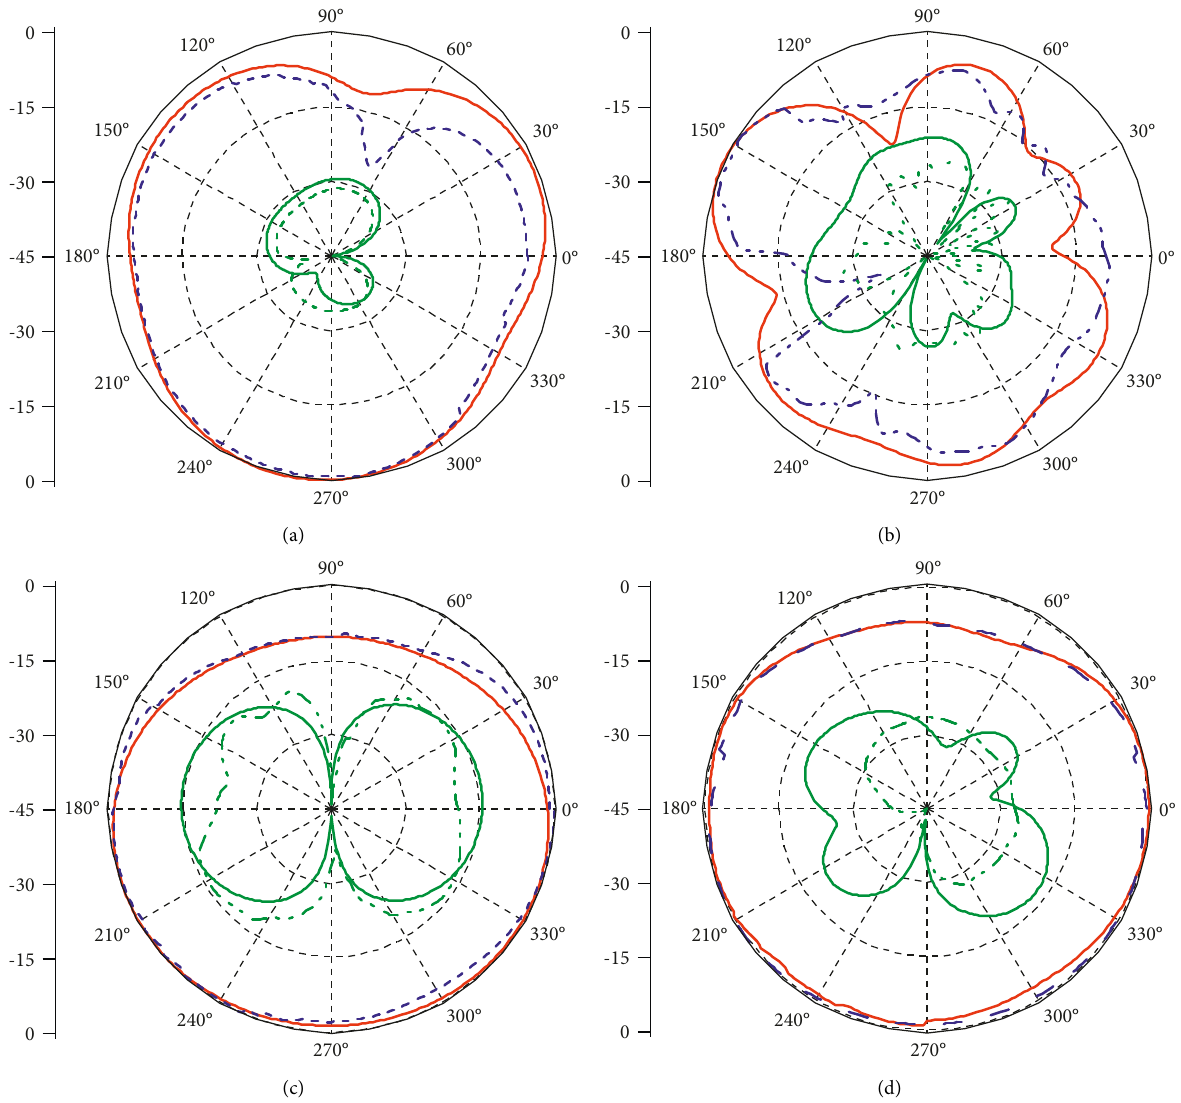
Figure 16: Simulated and measured normalized radiation patterns of antenna#2 at 2.4GHz and 5.8GHz. HFSS G Meas G , θ